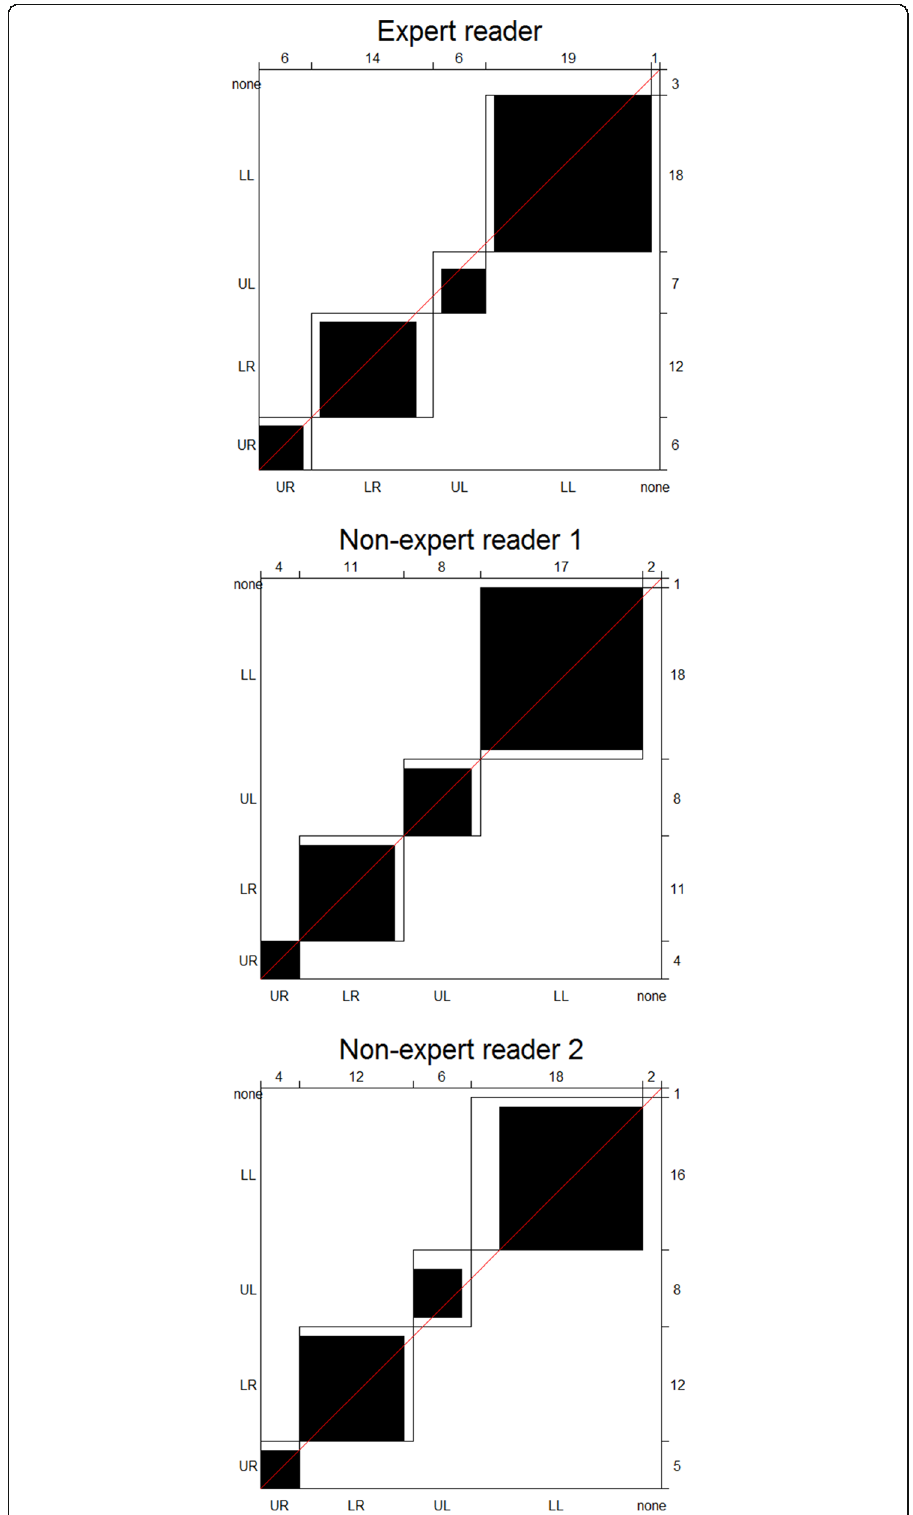
Fig. 2 (See legend on next